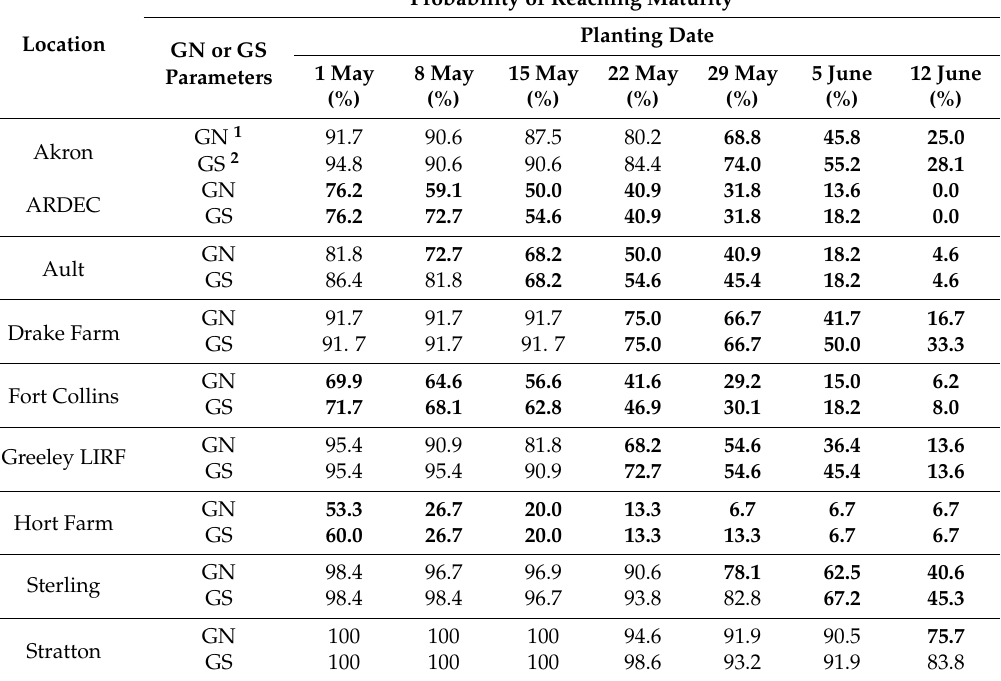
Table 3. Probability of reaching maturity for seven planting dates at nine locations in